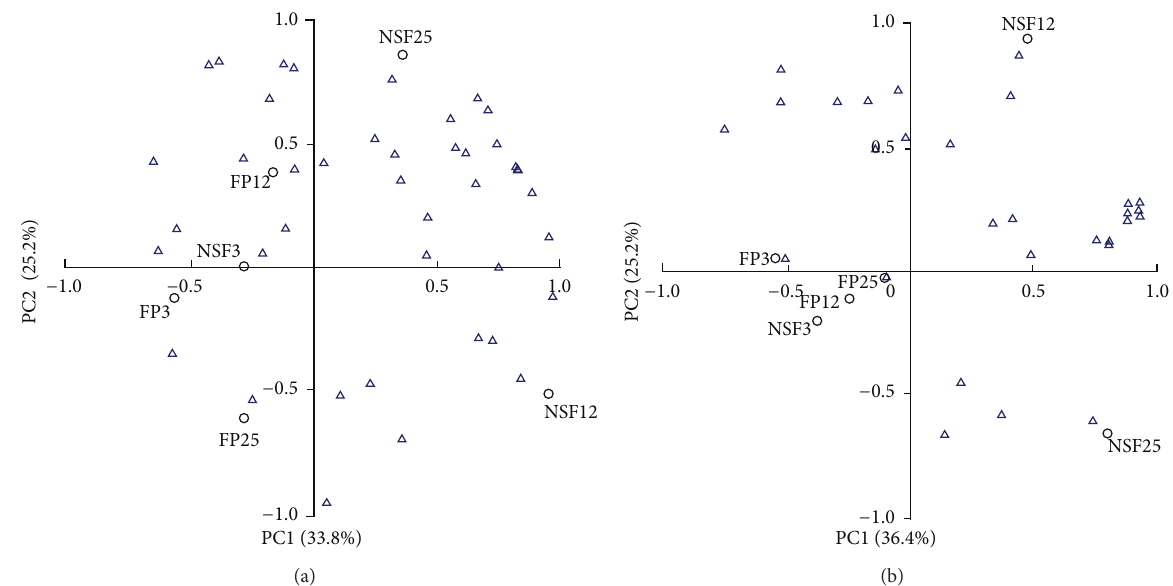
Figure 3: PCA depicted relationship between fungal (a) and bacterial (b) species in the rhizosphere of Pinus tabulaeformis and sampling sites. Open triangles indicated microbial